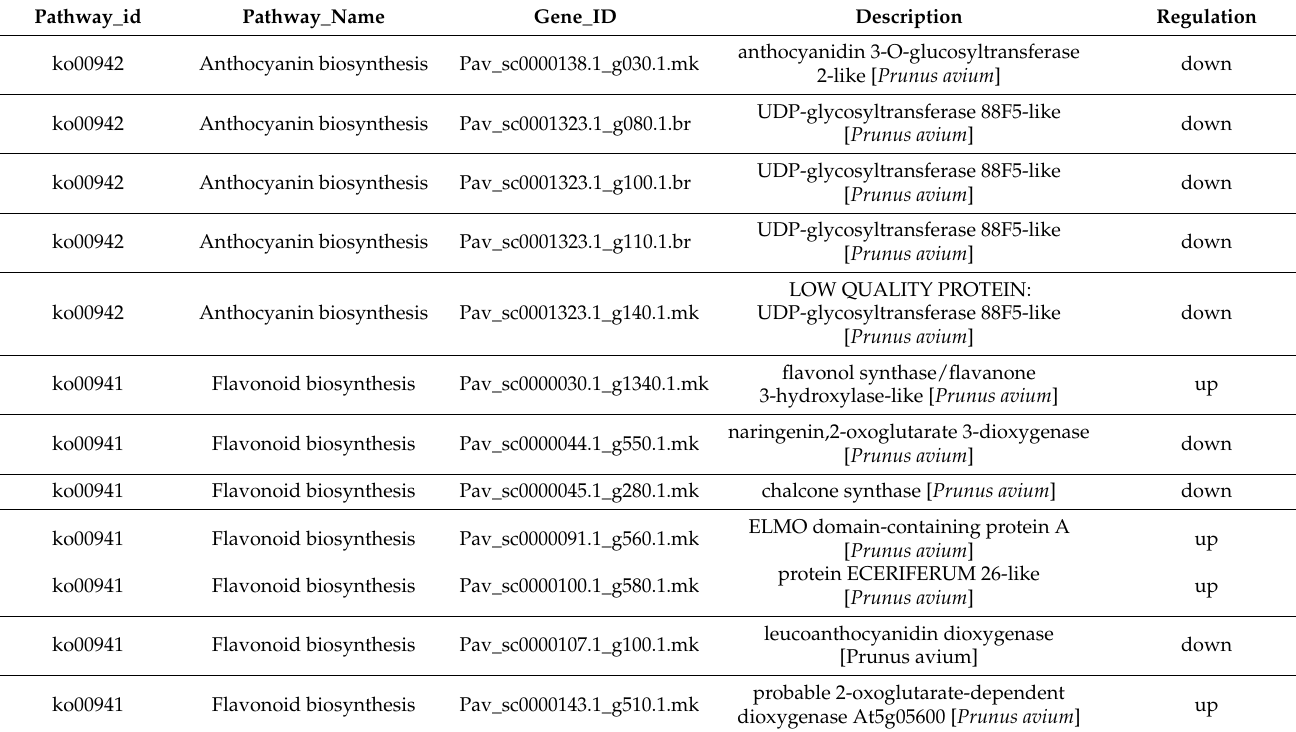
Table 1. Omics data integration of transcriptome and metabolome yields 44 DEGs in anthocyanin, flavonoid, and flavone and flavonol biosynthesis